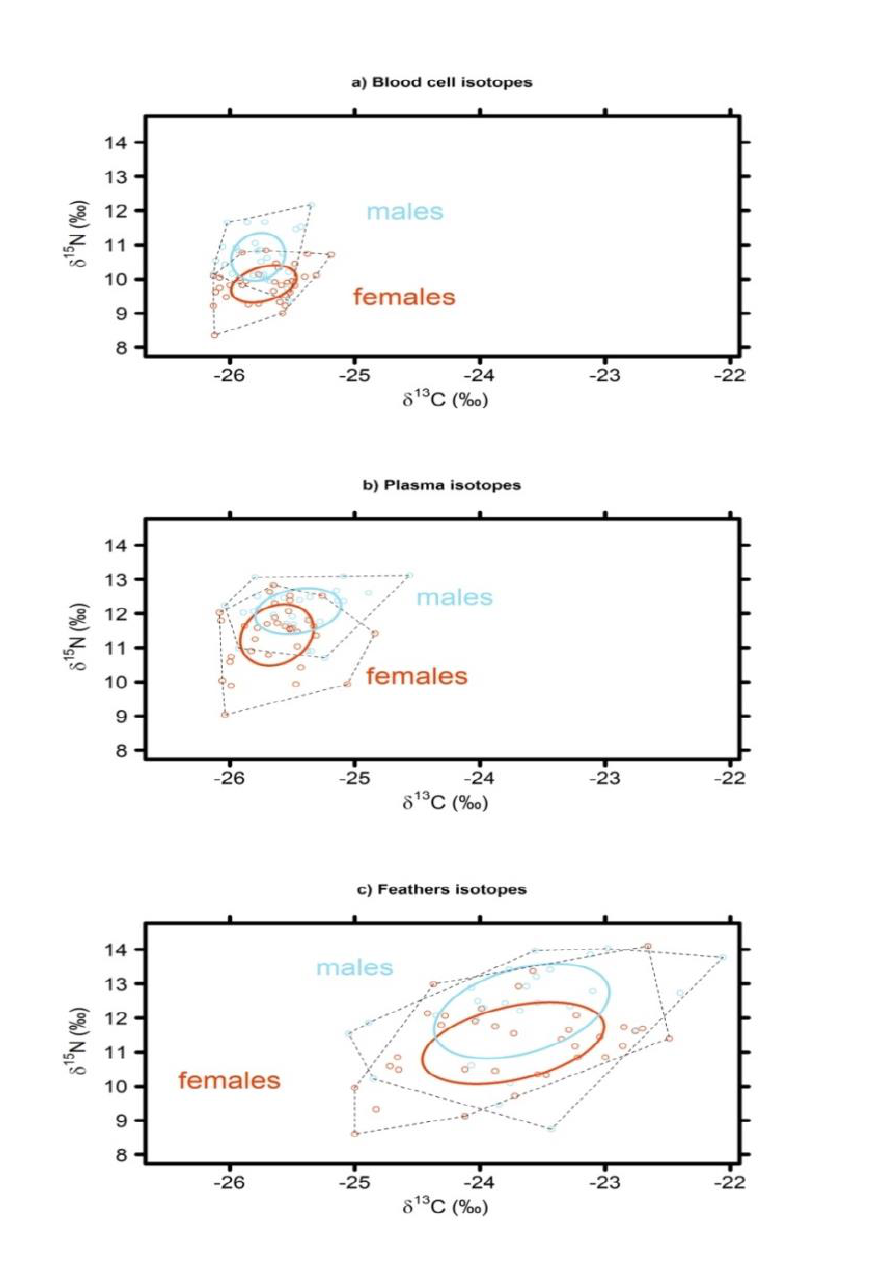
Figure 4. Isotopic niche area based on stable isotope values (  15 N and  13 C) in blood cells (top), plasma (middle) and body feathers (bottom) of male (blue) and female (red) snow petrels breeding at Ile des Pétrels, Pointe Géologie, Antarctica during the incubation period. The areas of the standard ellipses are represented by the solid lines, and the layman metric of convex hull area by black dotted lines.